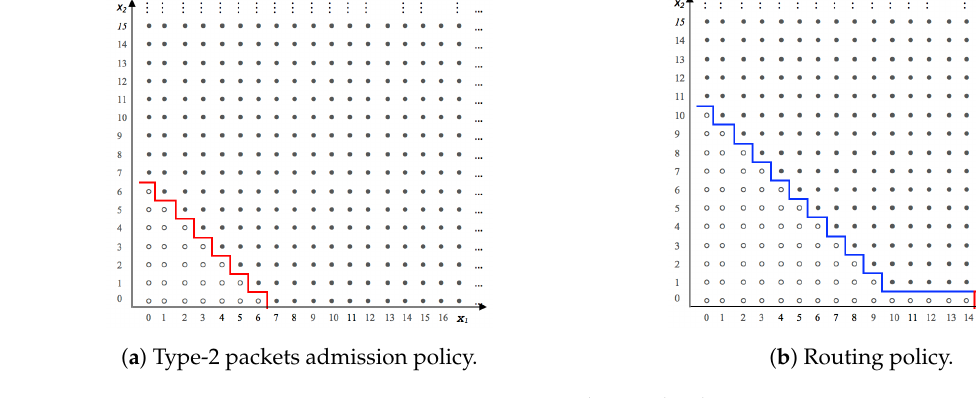
Figure 2. Optimal control